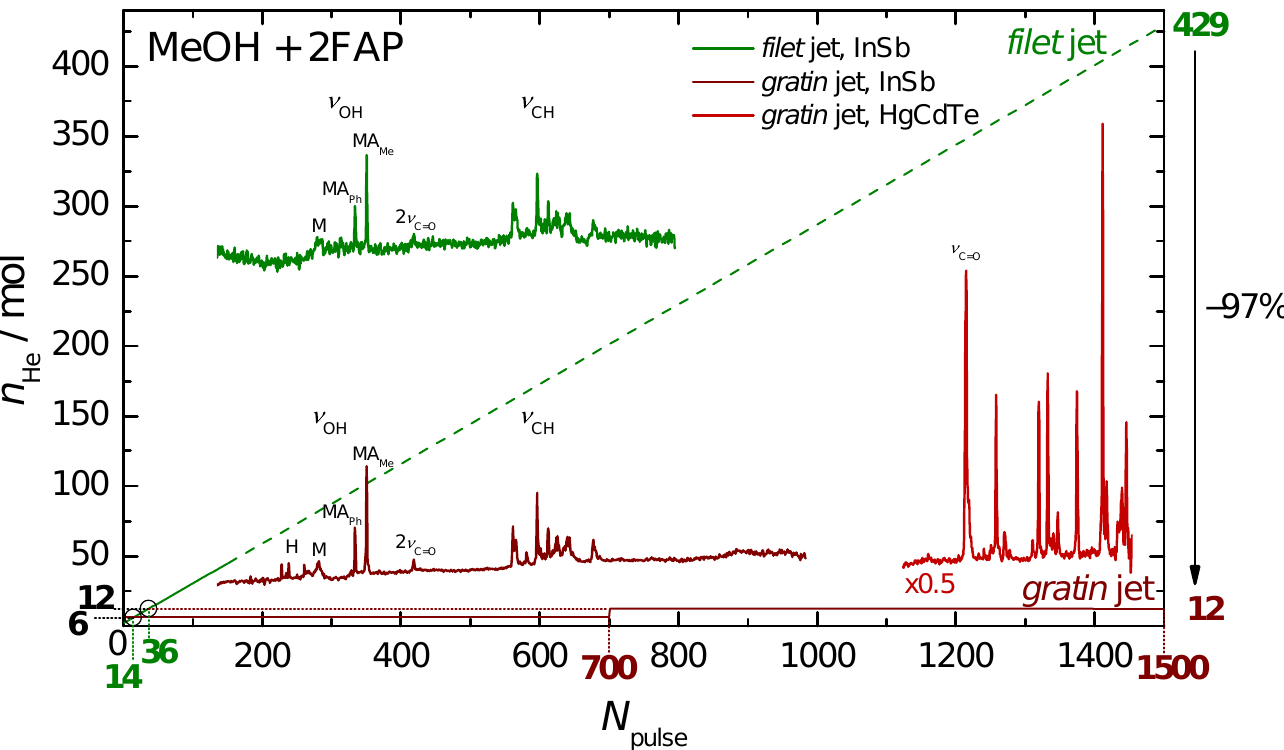
Figure 8. Comparison of helium consumption for measurements of MeOH+2FAP in He ( > 99.9% of the gas mixture) at the filet (green) and gratin (red) jet setups. At the filet jet, 150 pulses were measured (solid green line), and the helium consumption is extrapolated (dashed green line) to the 1500 scans measured at the gratin jet. At the gratin jet, the reservoir was filled twice, with the refill ocurring after 700 pulses (solid red line). The black circles indicate the intersections of the filet jet consumption line with the amounts of substance needed for one and two reservoir fillings at the gratin jet. The spectra recorded with a He consumption of 12 mol (36 pulses at the filet jet and 1500 pulses at the gratin jet) are shown as green ( filet jet), dark red ( gratin jet, InSb detector) and red ( gratin jet, HgCdTe detector) traces. The spectral regions ( ν OH : OH stretching range; ν CH : CH stretching range) and most important absorption signals (H: water; M: methanol monomer; MA Me/Ph : methanol-2-fluoroacetophenone dimer, bound on the methyl (Me) or phenyl (Ph) side; 2 ν C = O : C = O stretch overtone; ν C = O : C = O stretch) are